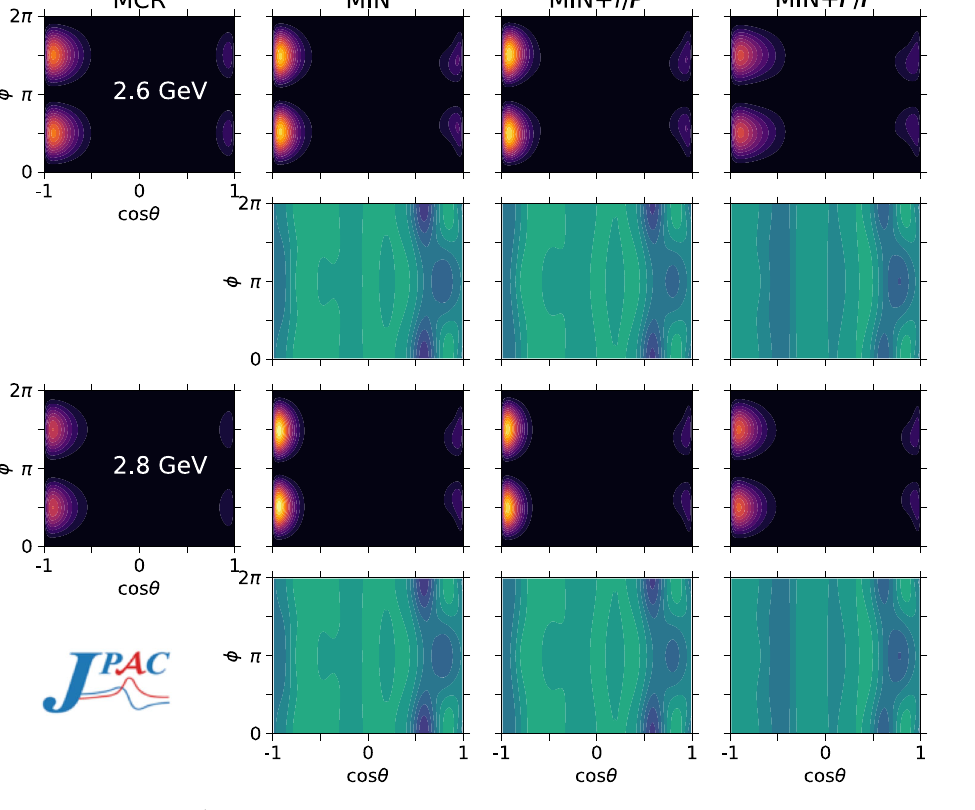
Fig. 18 Same as Fig. 14 for the η (cid:2) π channel